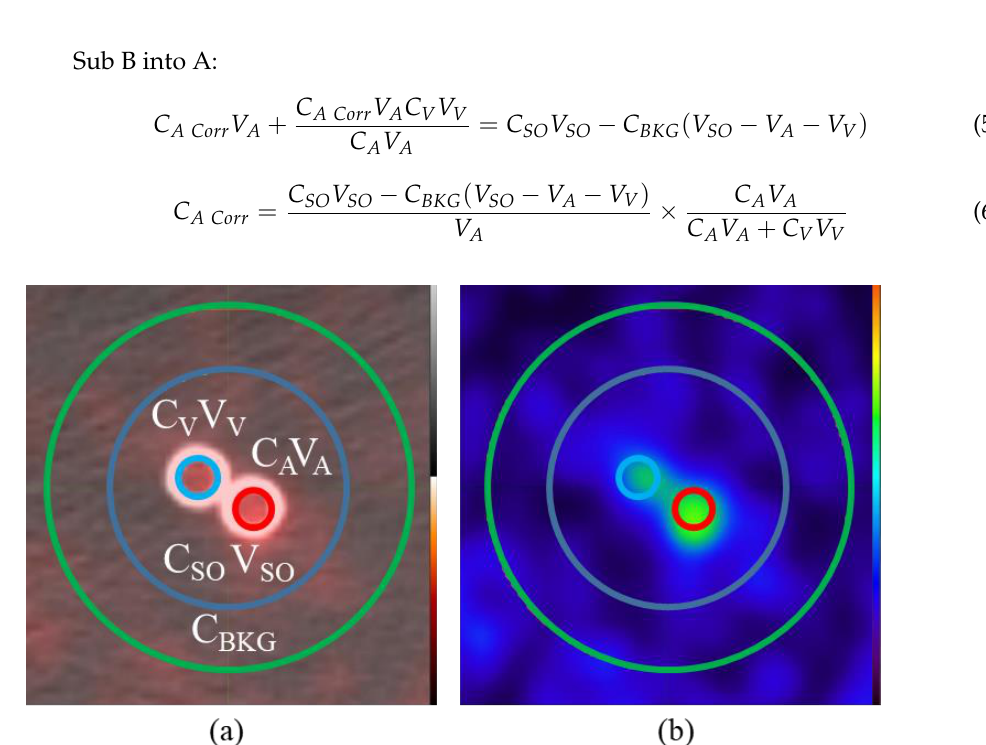
Figure 3. Partial volume correction in the presence of two signal functions. ( a ) In addition to the “spill-out” (C SO /V SO) and background activity (C BKG ), the C A /V A terms for the arterial input as well as new terms C V /V V representing the venous function are separately outlined. ( b ) “Spill-out” from these small ¼” tubes is easily observable on the PET image.